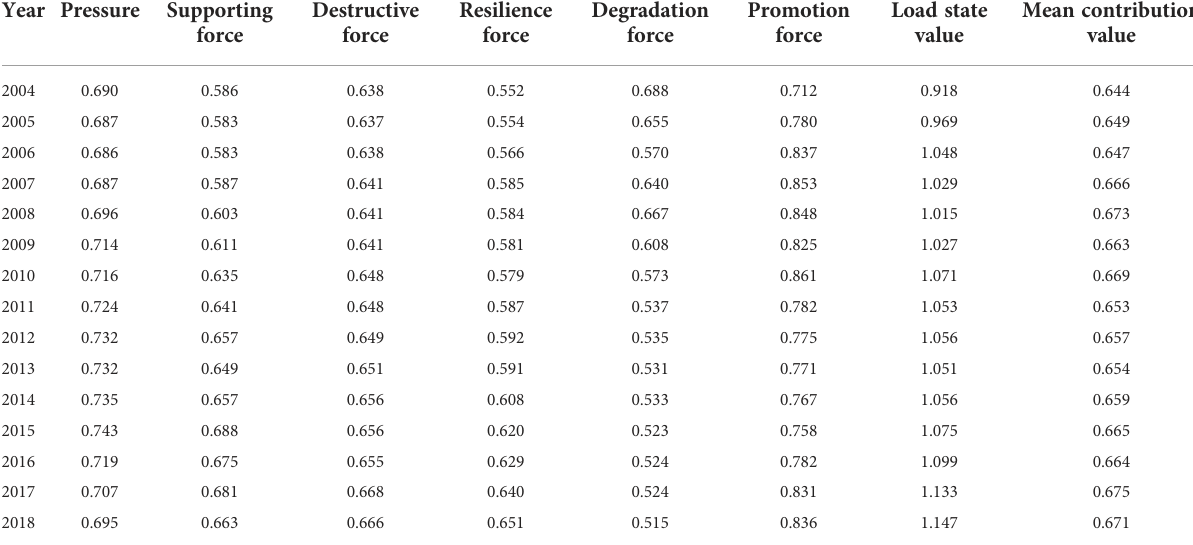
TABLE 3 The carrying status of the marine resources and environment in Zhejiang